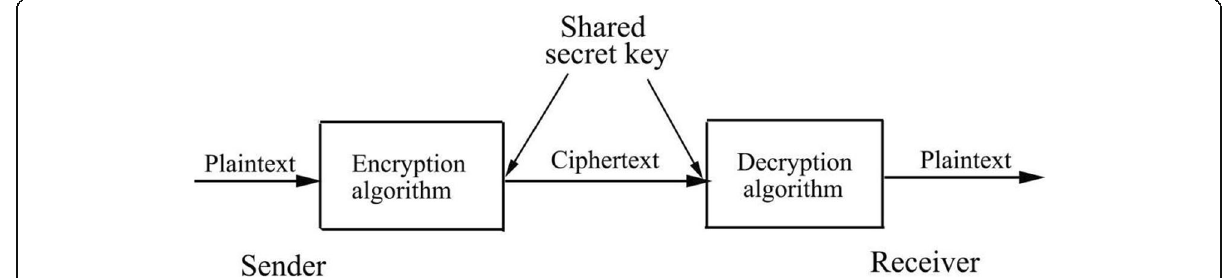
Fig. 7 Symmetric searchable encryption